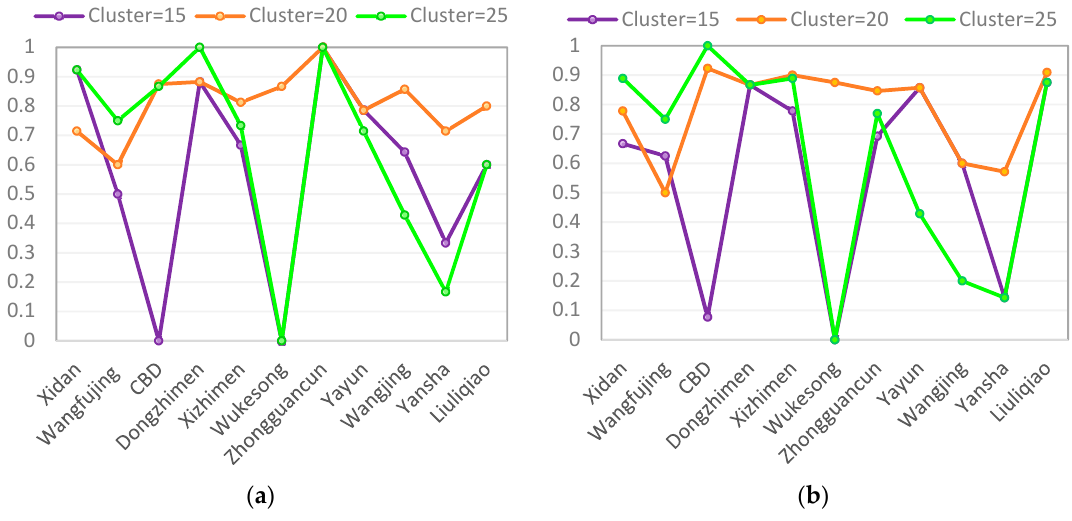
Figure 4. Prediction accuracy at 11 fixed locations: ( a ) During peak times; ( b ) During off-peak times.